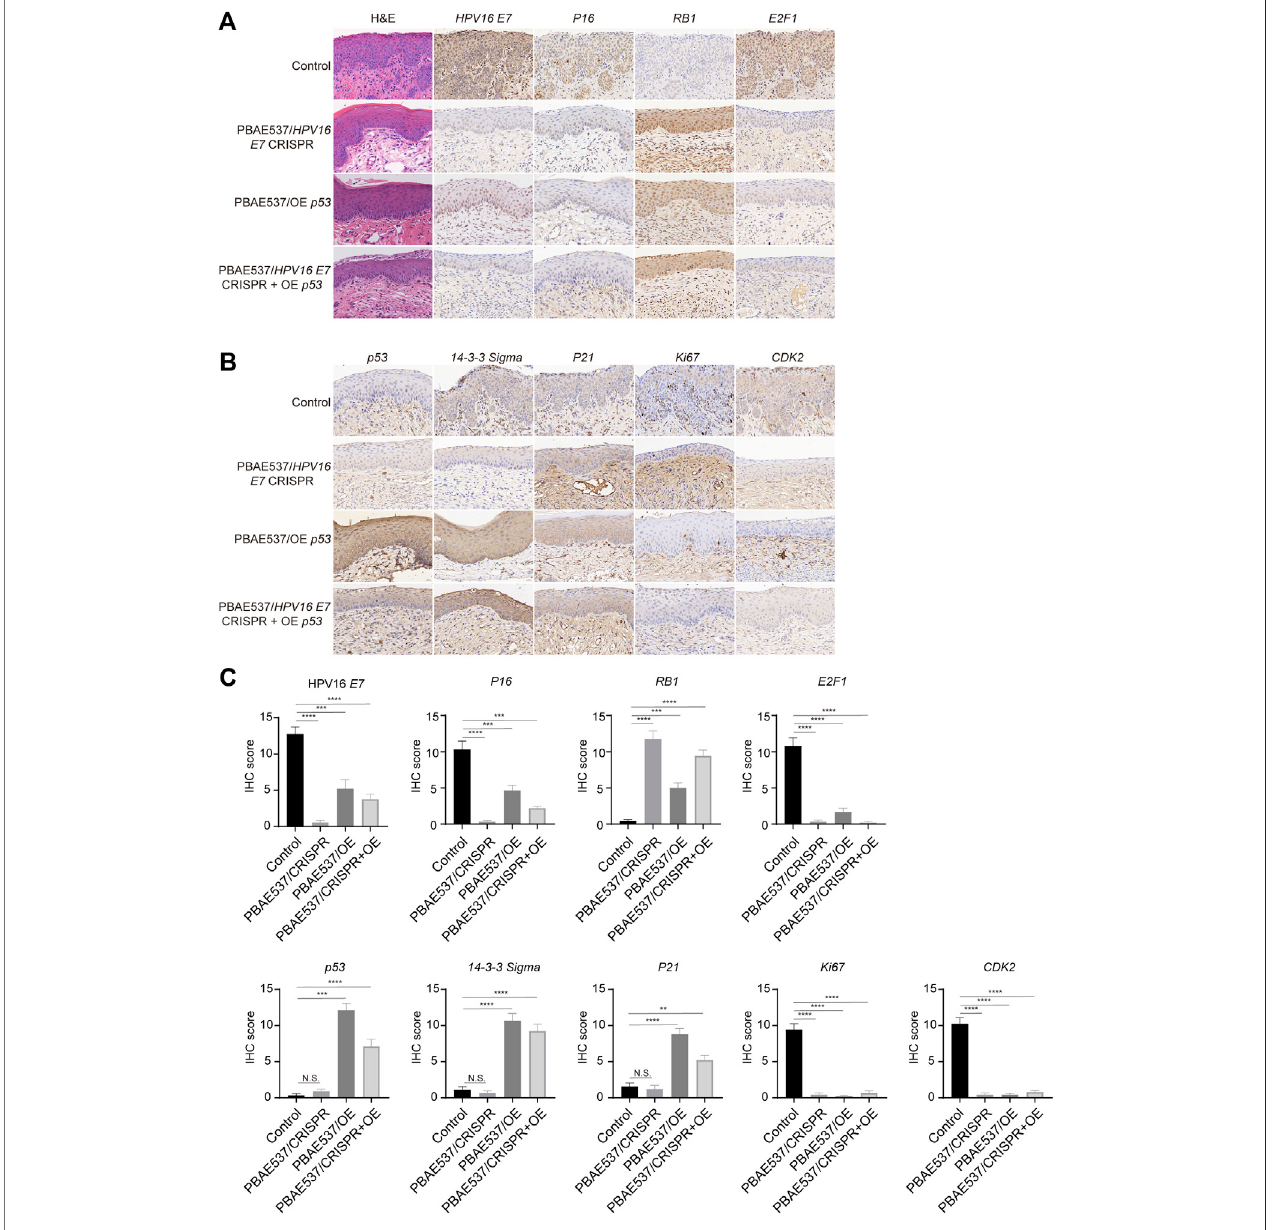
FIGURE 6 | Therapeutic effects of nanoparticles composed of PBAE537 and therapeutic plasmids targeting HPV16 E 7 and p53 K14-HPV16 transgenic mice. (A, B) RepresentativeimagesofHandEandIHCstainingand (C) comparisonofthecervicalepitheliumbetweenuntreatedHPV16transgenicmice(controlgroup)andthree othertargetedgroupstreatedwithnanoparticlescomposedofPBAE537andplasmids(60:1,10 μ gofplasmidsperdayfor20 dayscontinuously.IHCstainingindicators includedHPV16 E 7 , P16 , RB1 , E2F1 , p53 , 14-3-3 Sigma , P21 , Ki67 ,and CDK2 .Scalebars,20 μ m.Thedatarepresent themean±SEM( n =3).One-wayANOVA was used for statistical analysis, *: p < 0.05, **: p < 0.01, ***: p < 0.001, ****: p < 0.0001, N.S.: no signi fi cant